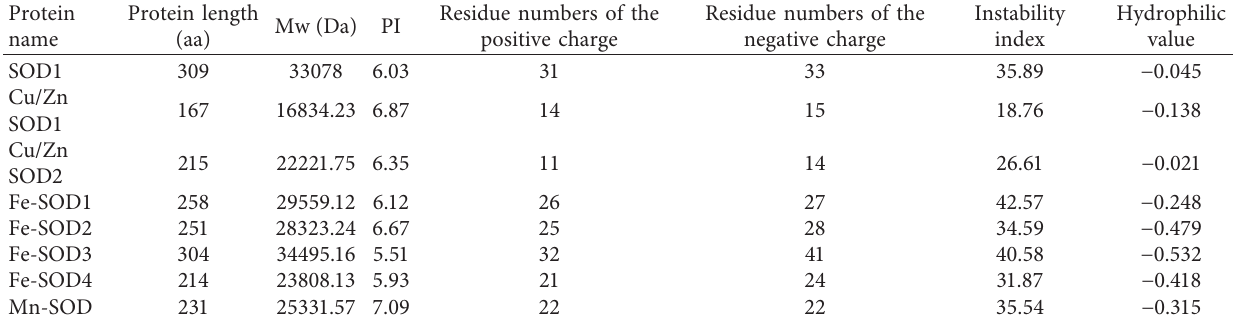
Table 2: Physiial and chemical properties of potato SOD genes.